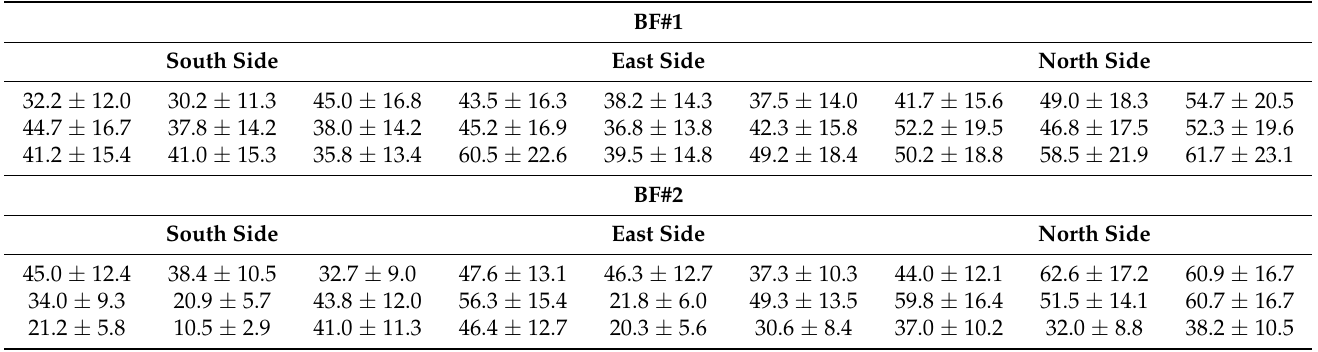
Table 2. Average woodchip moisture content (%) of each section over the entire monitoring period 1 .